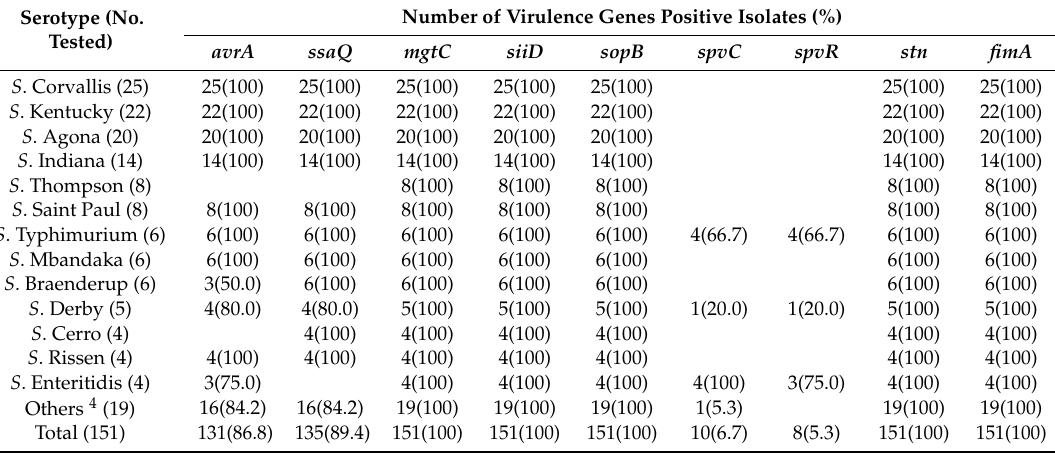
Table 5. Distribution of virulence genes among Salmonella isolates with di ff erent serovars. Serotype (No.